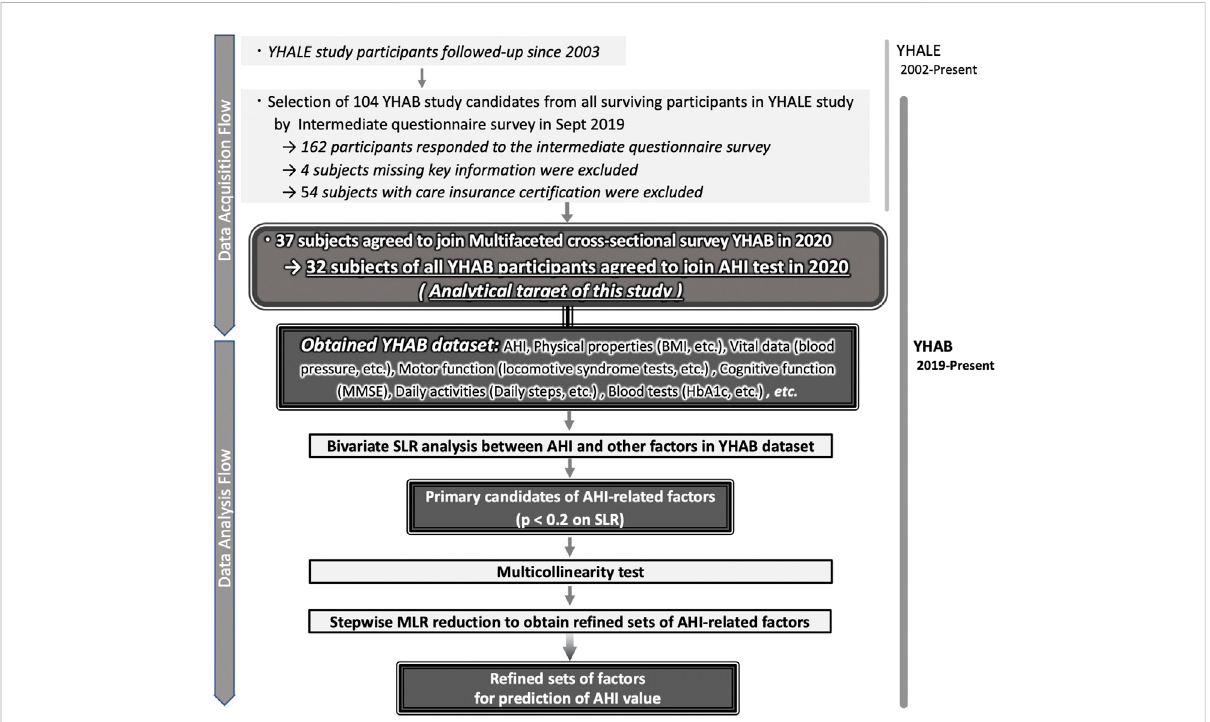
FIGURE 1 Selection of general factors in the study participants to estimate the AHI in older adults. (Top) Detailed description of the multifaceted, cross- sectional YHAB survey responses by the participants selected from among the survivors of the longitudinal Y-HALE study. (Bottom) Selection and re fi nements of the general factors to estimate the AHI from the YHAB datasets. AHI, apnoea-hypopnoea index; YHAB, Yamanashi Healthy Active Longevities Biobank for healthy aging biosciences; Y-HALE, Yamanashi Healthy-Active Life Expectancy; BMI, body mass index; SLR, simple linear regression; MLR, multiple linear